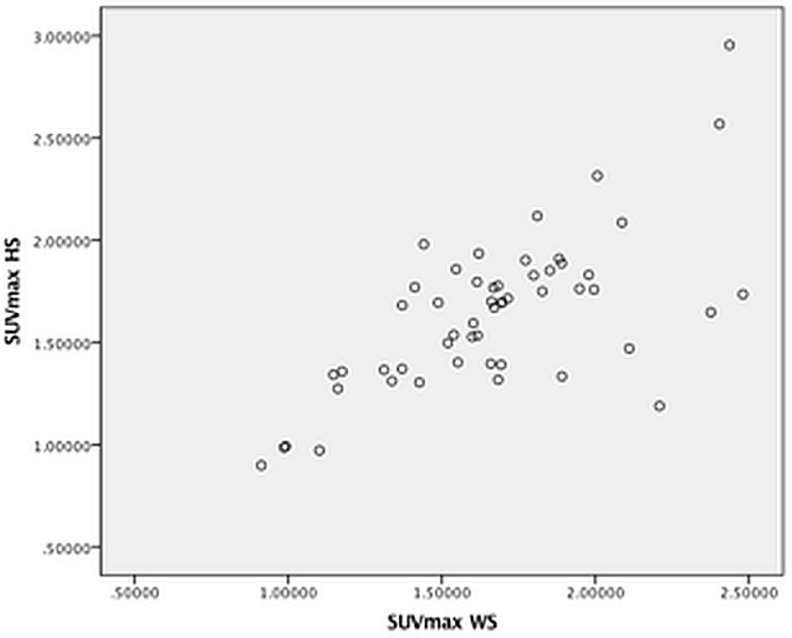
Scatter plot for SUVmax HS versus SUVmax WS. (HS = hot spot, WS = whole segment).